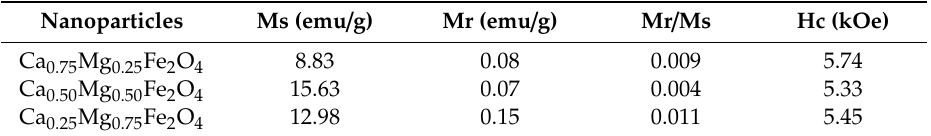
Table 2. Saturation magnetization (M s ), remnant magnetization (M r ), ratio M r / M s , and coercive field (Hc) of calcium-substituted magnesium ferrite nanoparticles.